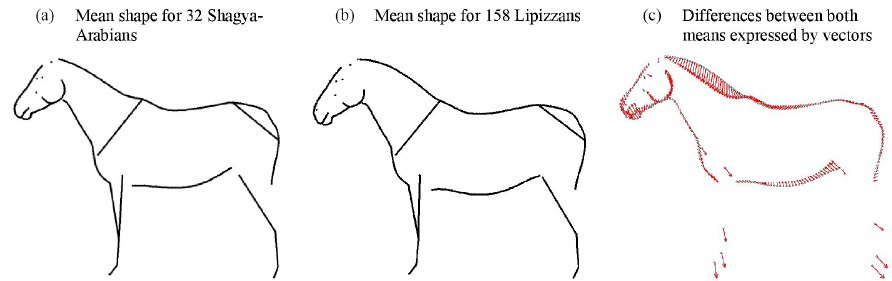
Figure 4. Mean shapes for 32 Shagya Arabians and 158 Lipizzan horses. The differences in landmark configurations between both mean shapes are shown in panel (c) expressed by vectors, which illustrate the shape transitions from Lipizzan to Shagya Arabian phenotype.